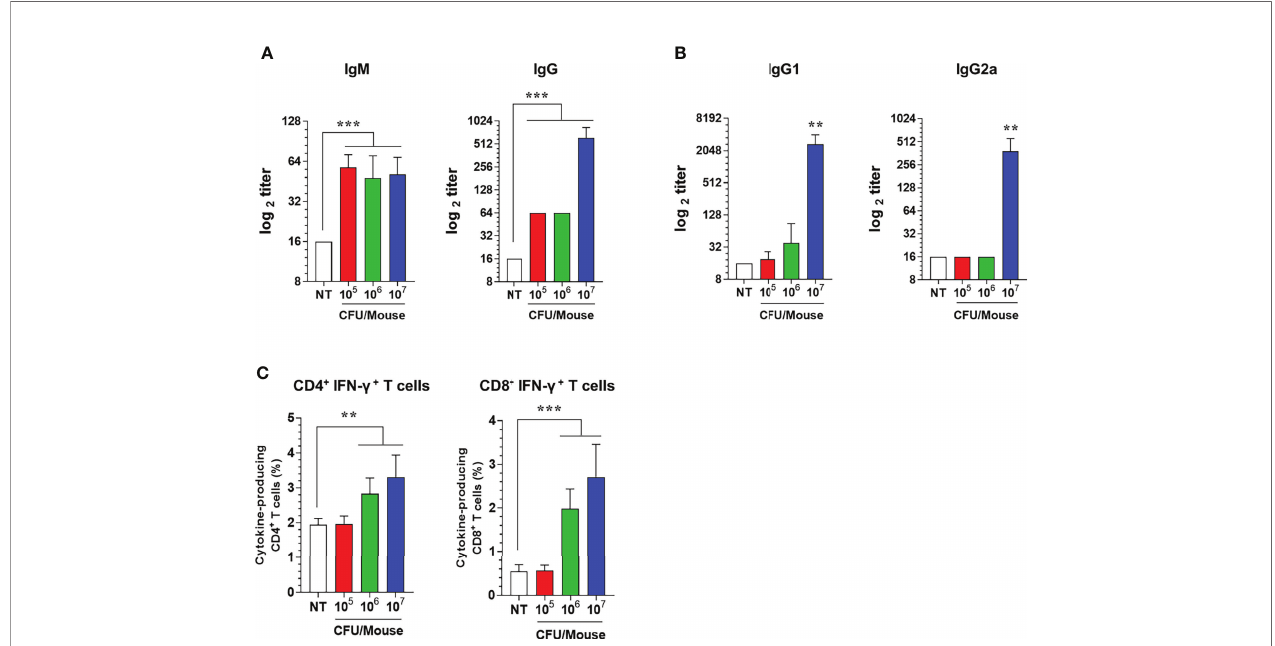
FIGURE 3 | Humoral and cellular immune responses induced by i.m. immunization of ATOMSal-L6. C57BL/6 mice (n = 5 per group) were immunized i.m. with 10 5 , 10 6 , or 10 7 CFU of ATOMSal-L6 thrice at two-week intervals. (A, B) Humoral immune response. Serum levels of Salmonella -speci fi c IgG and IgM were analyzed at 7 days following the last immunization (A) . Subclass levels of Salmonella -speci fi c IgG1 and IgG2a were analyzed at 7 days subsequent to the last immunization (B) . Data are representative of three independent experiments and are presented as the mean ± standard deviation. (C) Cellular immune response. Single cell suspensions of spleen were re-stimulated with 10 m g/mL ST WT lysate for 12 h and ST-speci fi c CD4 + and CD8 + T cells were analyzed. Percentages of activated CD4 + and CD8 + T cells in spleens of vaccinated mice. Data were presented as mean ± standard deviation. *P < 0.05, **P < 0.01, ***P < 0.001, compared to unvaccinated